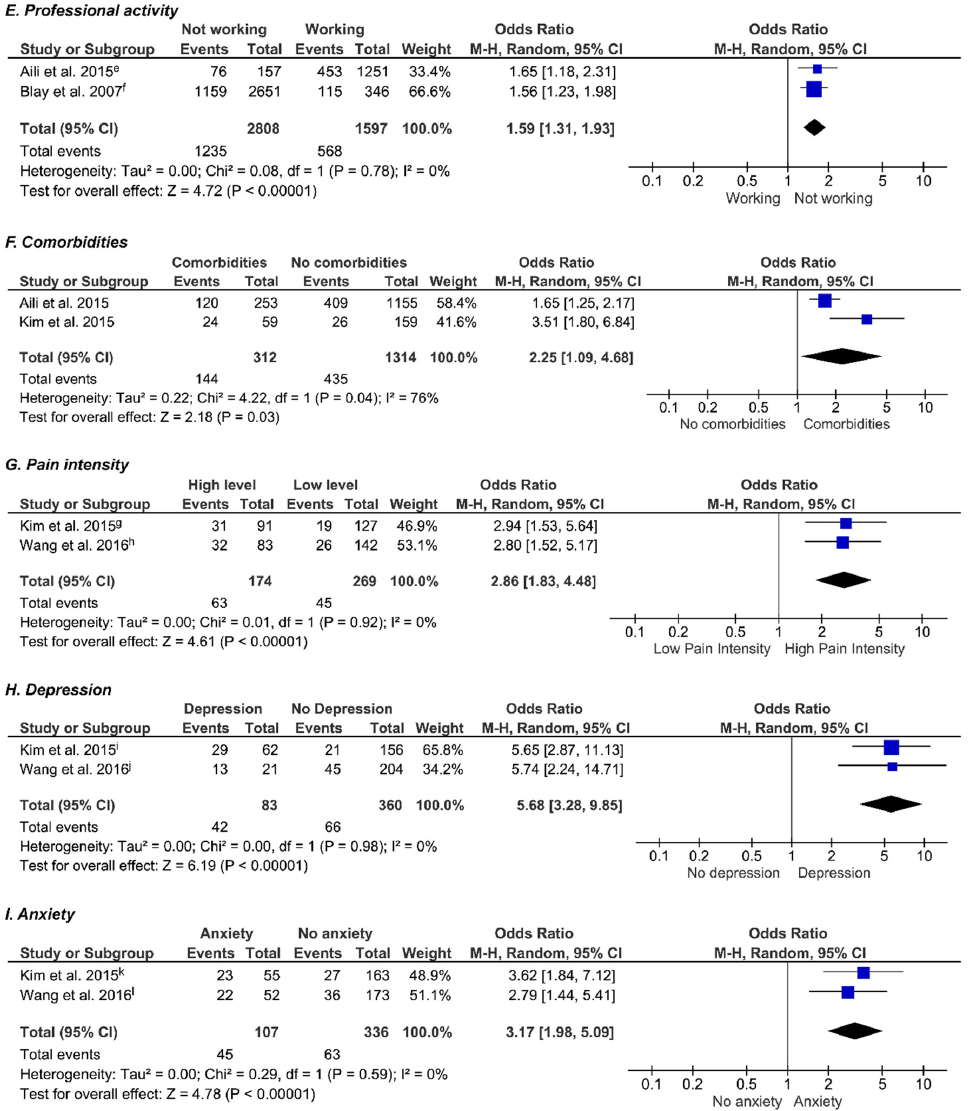
Figure 2. Forest plots showing odds ratios of several potential associated factors with insomnia in people with chronic spinal pain. A meta-analysis is conducted for the factors sex ( n = 12,722), age (n = 1626), body mass index ( n = 10,886), physical activity ( n = 10,796), professional activity ( n = 4405), comorbidities ( n = 1626), pain intensity ( n = 443), depression ( n = 443) and anxiety ( n = 443). Every blue box represents the observed odds ratio of the corresponding study. The size of every blue box is proportional to the weight of the study in the meta-analysis. The confidence intervals are represented by the horizontal lines through the blue boxes. The pooled odds ratio is represented by a black diamond, with the lateral tips of the diamond representing the associated confidence interval. Abbreviations: CNP, chronic neck pain; CLBP, chronic low back pain. a Aili et al. defined younger participants as people < 45 years [46]. b Kim et al. defined younger participants as people < 65 years [39]. c Blay et al. dichotomized physical activity in Yes/No but did not provide any detail about the level of physical activity used as a cut-off [36]. d Mork et al. defined physically active people as people performing more than one (accumulated) hour of exercise per week [41]. e Aili et al. defined performing no professional activity as “Unemployed for the last year/not working” [46]. f Blay at al. dichotomized professional activity as active/non-active but did not provide any further details [36]. g Kim et al. defined a high pain score as NRS ≥ 7 [39]. h Wang et al. defined a high pain score as VAS ≥ 7 [45]. i Kim et al. defined depression as a score of at least 8 on the HADS-D [39]. j Participants in the study of Wang et al. were screened by a board-certified psychiatrist for the presence of a current major depressive episode [45]. k Kim et al. defined depression as a score of at least 8 on the HADS-A [39]. l Participants in the study of Wang et al. were screened by a board-certified psychiatrist for the presence of any anxiety disorders